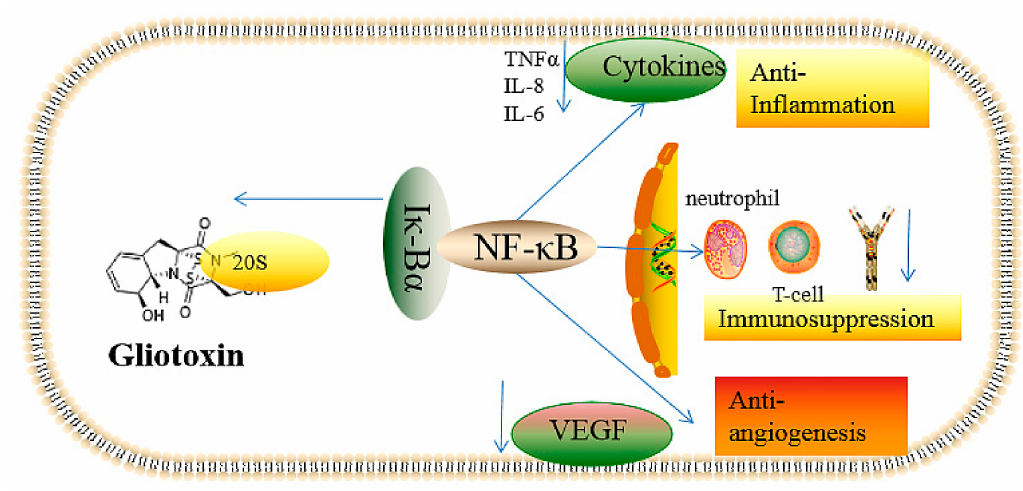
Figure 2. The cytotoxic effects, including immunosuppression, antiangiogenesis, and anti-inflammation, of gliotoxin mediated by NF- κ B. The arrow to the left indicates that gliotoxin can detach 20S protease from I κ -B α , thus inhibiting the activation of NF- κ B. The downward arrow indicates the down-regulation caused by the inactivation of NF- κ B mediated by